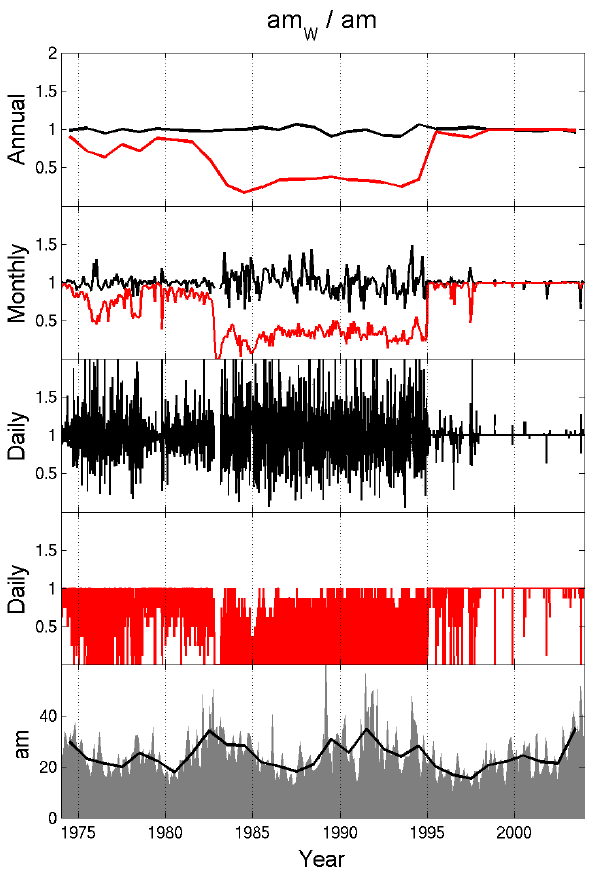
Fig. 6. Ratio of am w to am at a variety of timescales. In the upper Figure 6. four panels the solid black line is the ratio of am w to am , the solid red line is the data coverage: we display these on the same panel for annual and monthly timescales, but the high-frequency variability of both on daily timescales required us to use separate panels (3 and 4). In the fifth, bottom panel, the solid black line is the average value of am at annual timescales and the grey histogram the average value of am at monthly timescales. There is no apparent connection between am magnitude and the am w to am